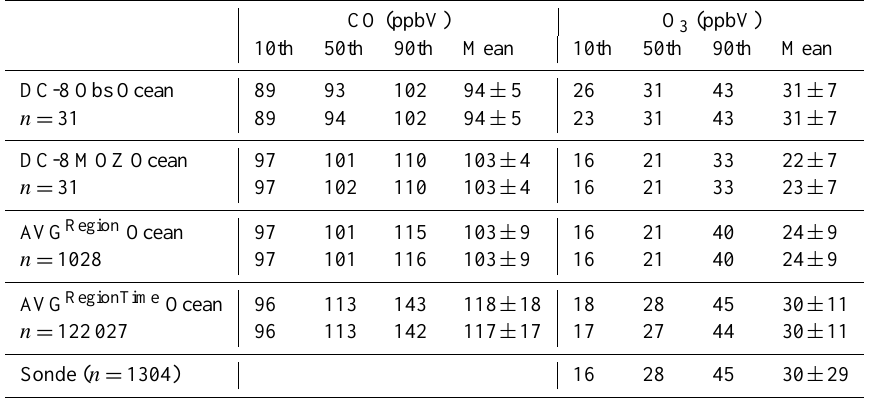
Table 3. Percentiles, mean and standard deviation for DC-8 Ocean Data Sets and ozonesonde data for the 0–1km altitude range. The second row, where given, gives results when US fire influenced data are omitted. The numbers in the furthest left column give the number of data points that went into the no-fire impacted statistics if filtering was applied.